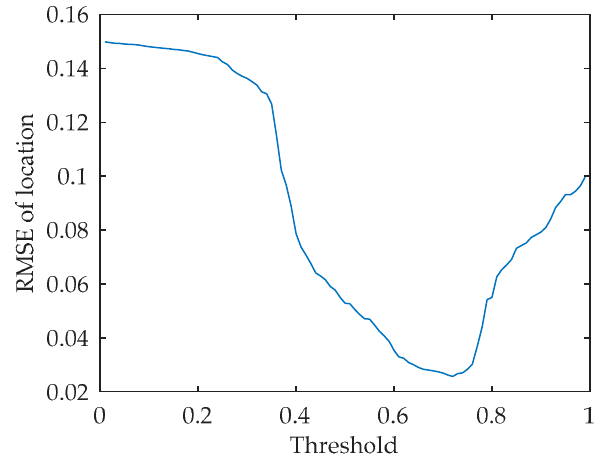
Figure 6. Accuracy variation at different thresholds.